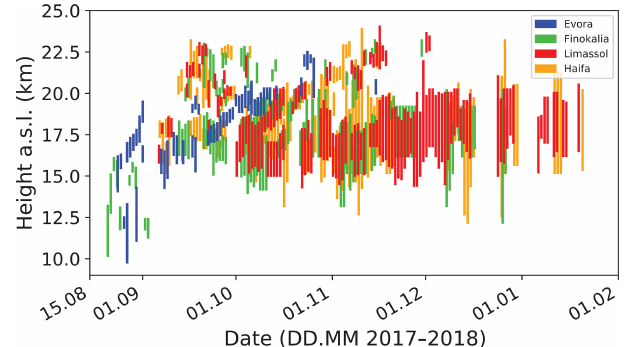
Figure 7. All individual day-by-day smoke observations of the 532nm particle linear depolarization ratio (PLDR, from all con- tributing stations, including several Lindenberg observations at 355nm). Colors indicate different depolarization value ranges. The depolarization ratio decreased with time because of the removal of the larger nonspherical smoke particles and/or the change in the shape characteristics (from nonspherical to spherical particle shape).